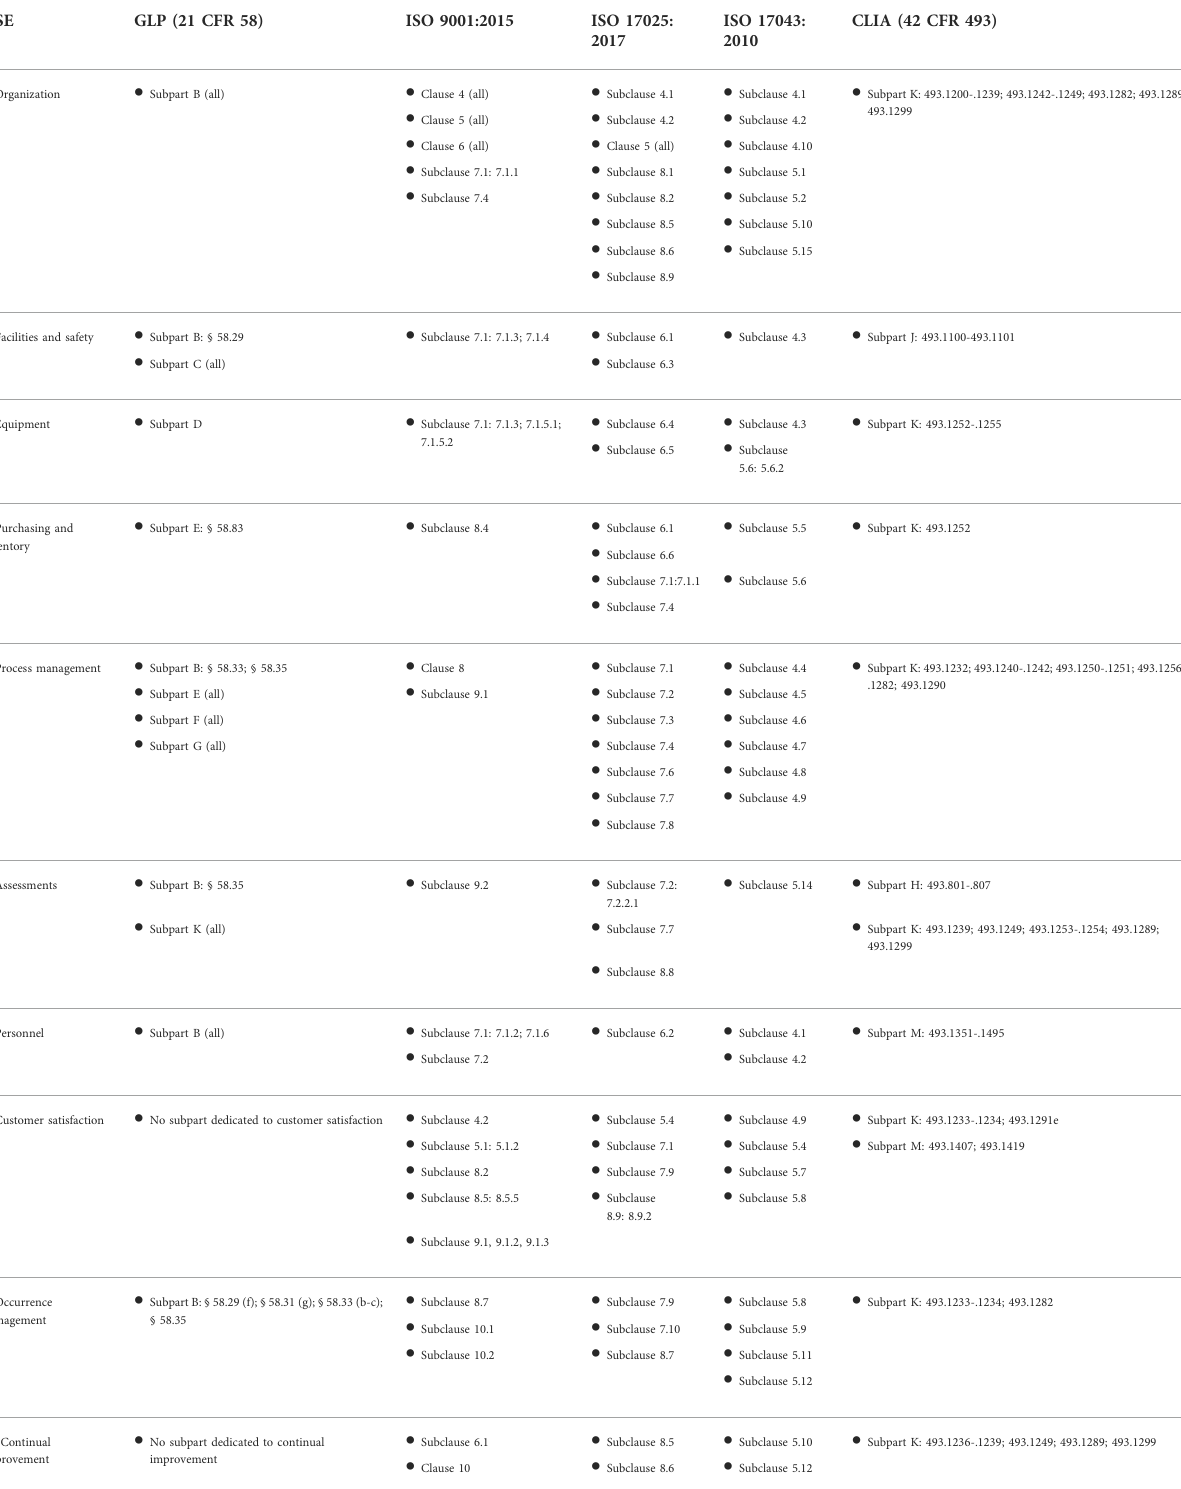
TABLE 1 Crosswalk of Common Quality Management Framework Documents* *Note: This table displays a non-exhaustive list of example applicable clauses, subclauses, subparts, and